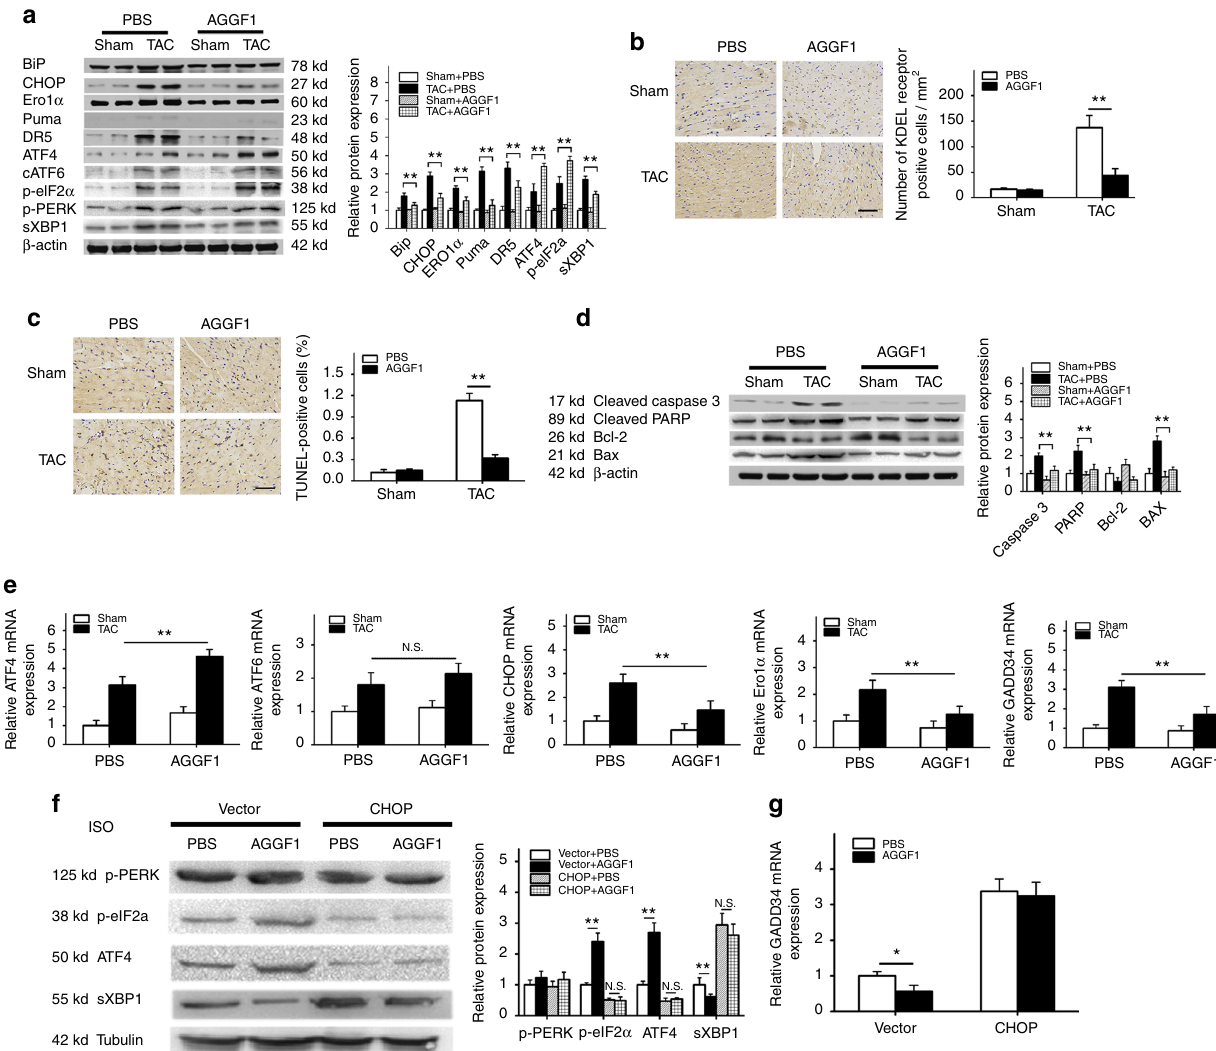
Fig. 4 AGGF1 protein therapy regulates ER stress signaling and apoptosis. TAC or sham mice were treated with AGGF1 or PBS ( left ) and characterized ( n = 6/group, ** P < 0.01). a AGGF1 regulates TAC-induced ER stress signaling in mice. Protein extracts from heart samples were used for western blot analysis for ER stress signaling markers ( n = 6/group, ** P < 0.01). b Representative images for immunostaining analysis of heart sections for KDEL receptor-positive cells. Scale bar , 50 μ m. c Representative images of TUNEL staining for apoptosis from heart sections. Scale bar , 50 μ m. d Western blot analysis for apoptosis markers in heart tissues ( n = 6/group, ** P < 0.01). e Real-time RT-PCR analyses for ATF4 , ATF6 , CHOP , Ero1 α , and GADD34 in heart tissues from TAC or sham mice treated with AGGF1 or PBS ( n = 5/group, ** P < 0.01). f Western blot analysis showing that AGGF1 protein treatment increased the levels of ATF4 and p-eIF2 α , and decreased the level of sXBP1 in H9C2 cells treated with ISO for 48 h. The effects of AGGF1 were abolished by overexpression of CHOP by transient transfection of an expression plasmid as compared with the empty vector. No effect was observed for p-PERK ( n = 3/group, ** P < 0.01, N.S. , Non-signi fi cant). g Real-time RT-PCR analysis for GADD34 in H9C2 cells transfected with an expression plasmid for CHOP or empty vector control, and then treated with ISO in combination with AGGF1 or PBS for 48 h ( n = 3/group, * P < 0.05). Data are shown as the mean ± s.d. from at least three independent experiments. For a – e , statistical analysis was carried out by a Student ’ s two-tailed t -test; for f , g , statistical analysis was carried out by one-way analysis of